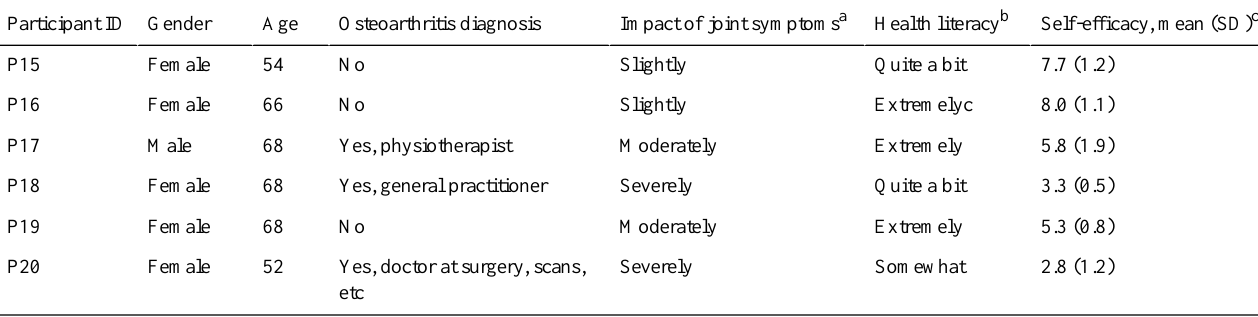
Table 3. Registered participant demographics (phase